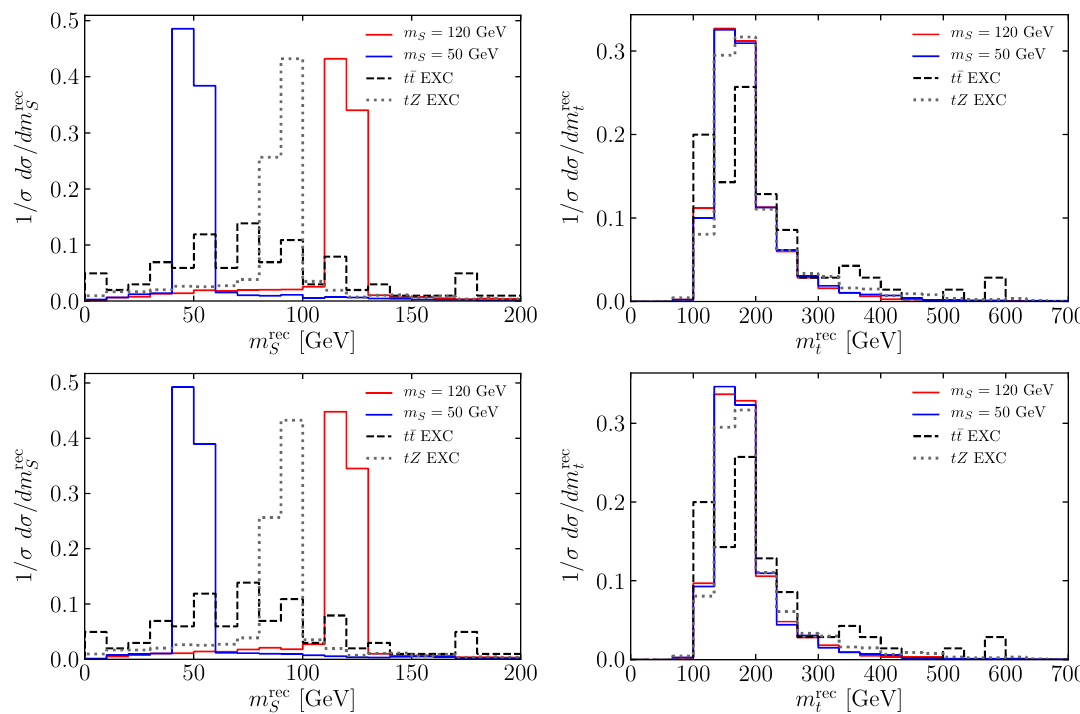
Figure 3 . The reconstructed scalar (left) and top (right) mass in the analysis proposed for t ! Sq , S ! (cid:22) + (cid:22) (cid:0) . In the upper (bottom) panel, q = c ( u ). We represent the distributions of two signal benchmark points and the two major background components, after the cut on the particle muons are included. The distributions assume a collected luminosity of L = 150 fb (cid:0) 1